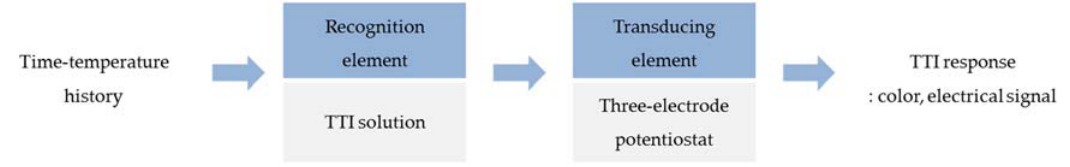
Figure 1. Construction of the biosensor system with time-temperature integrator (TTI) function.